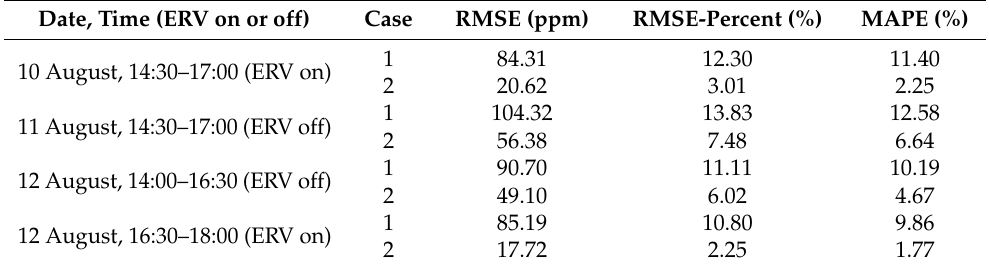
Table 6. CO 2 concentration test result and prediction tool result RMSE and MAPE